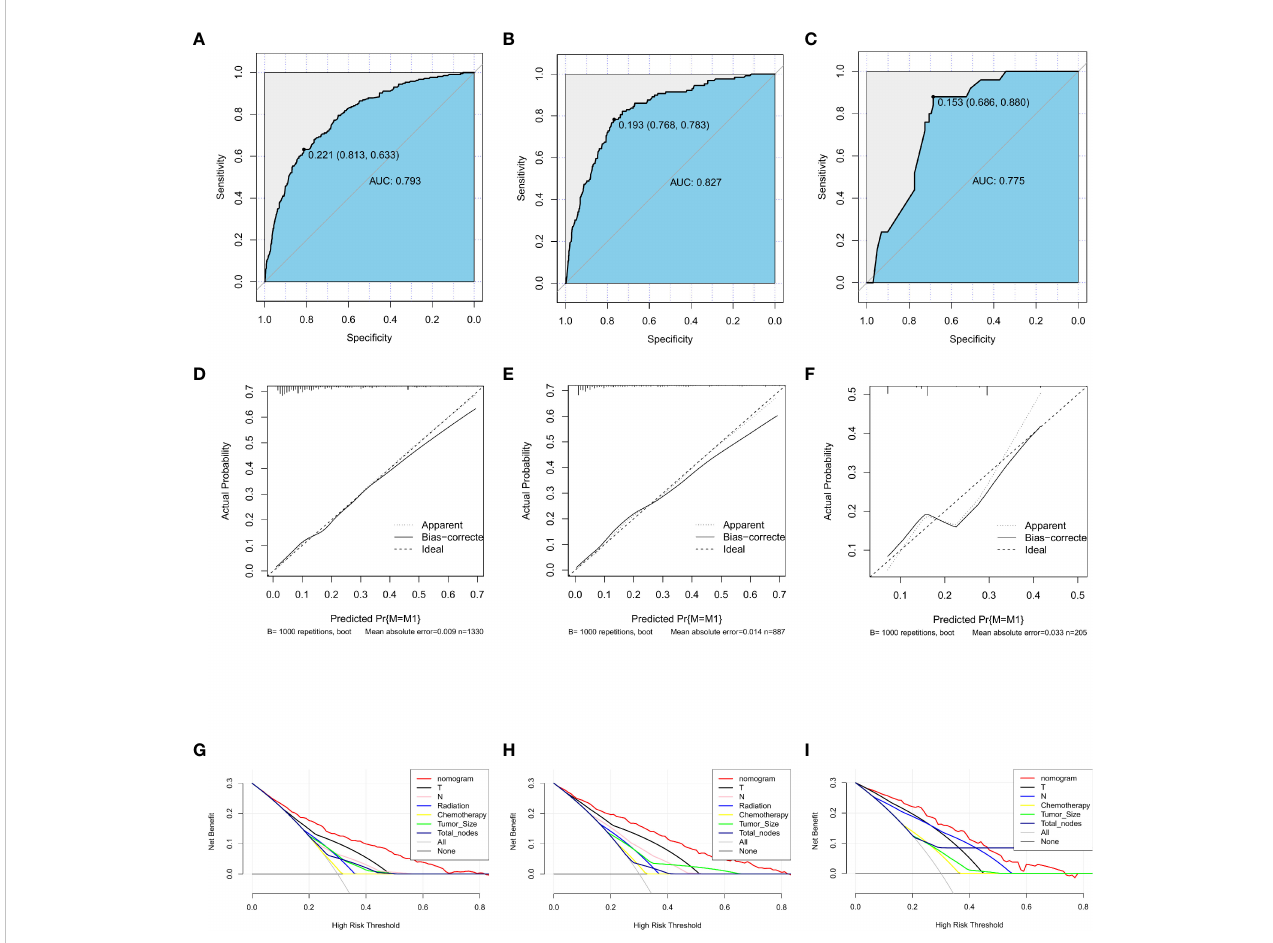
FIGURE 5 Training, testing, and validation sets of receiver operating characteristic (ROC) curves (A – C) , calibration curves (D – F) , and discriminant curve analyses (DCA) (G – I) for early-onset GC. GC, gastric